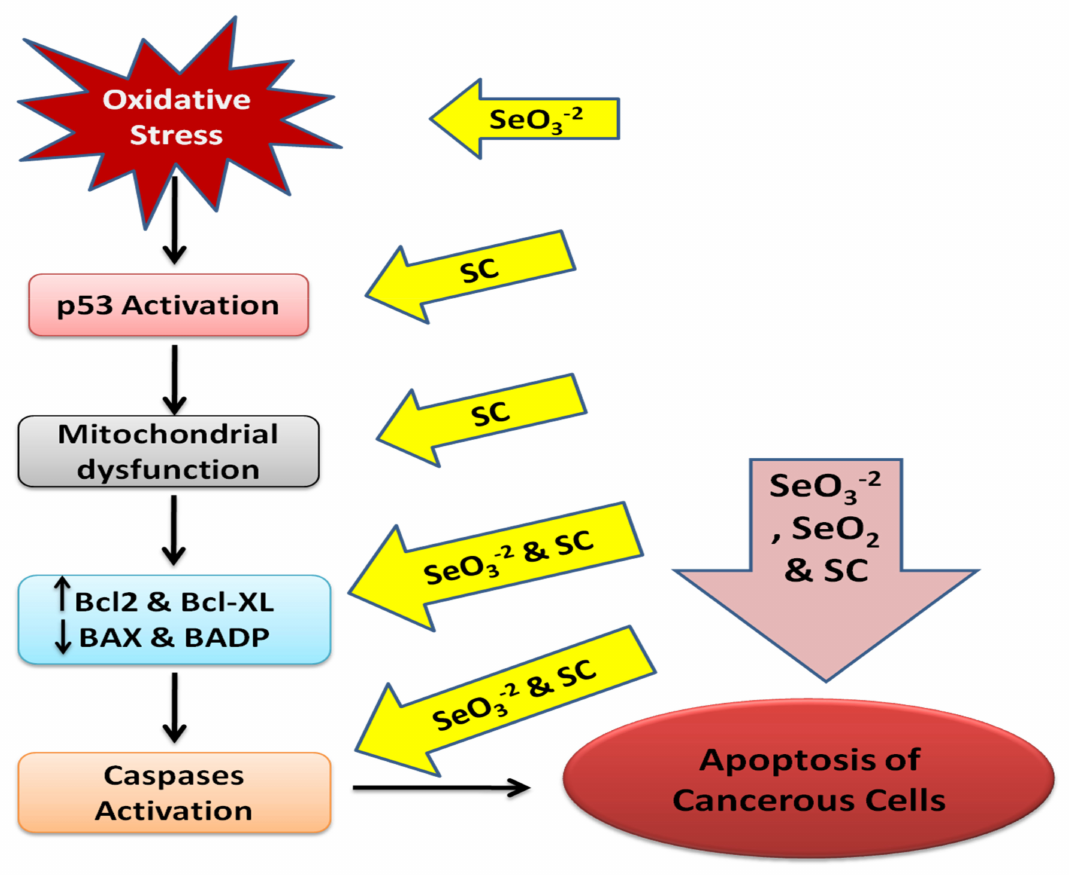
Figure 2. Selenium and derived compounds as a model for apoptosis targeting in cancer. Selenocysteine (SC), selenite (SeO 3 − 2 ), and selenium dioxide (SeO 2 ) act on different pathways of the apoptosis of cancerous cells via activating p53, caspase-9, Bcl 2, and inhibiting Bcl-2 − associated x gene (BAX). Increase ( ↑ ); decrease ( ↓